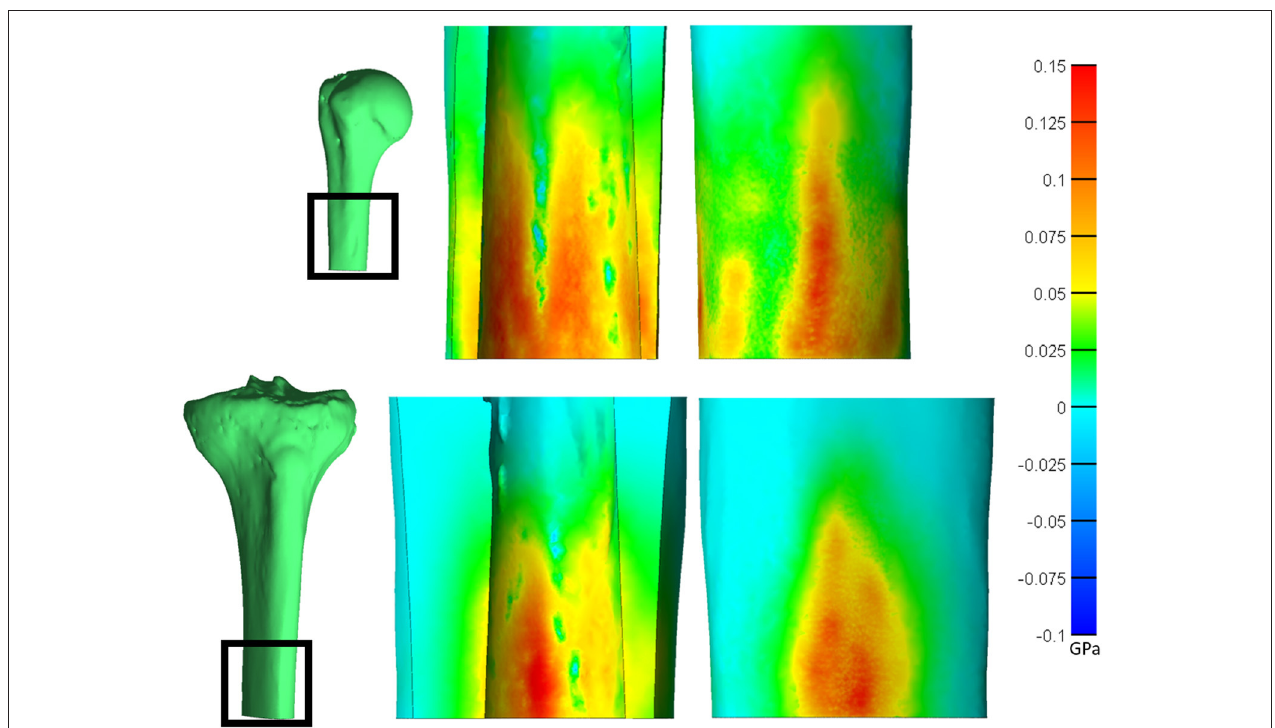
FIGURE 6 | Saggital cross-section of the humerus (top) and tibia (bottom) showing the endosteal (middle) and periosteal (right) surfaces. Heat map represents the first principal stress. Both bones have a normalized size of + 3. *Relative sizes of the bones are approximately to scale.